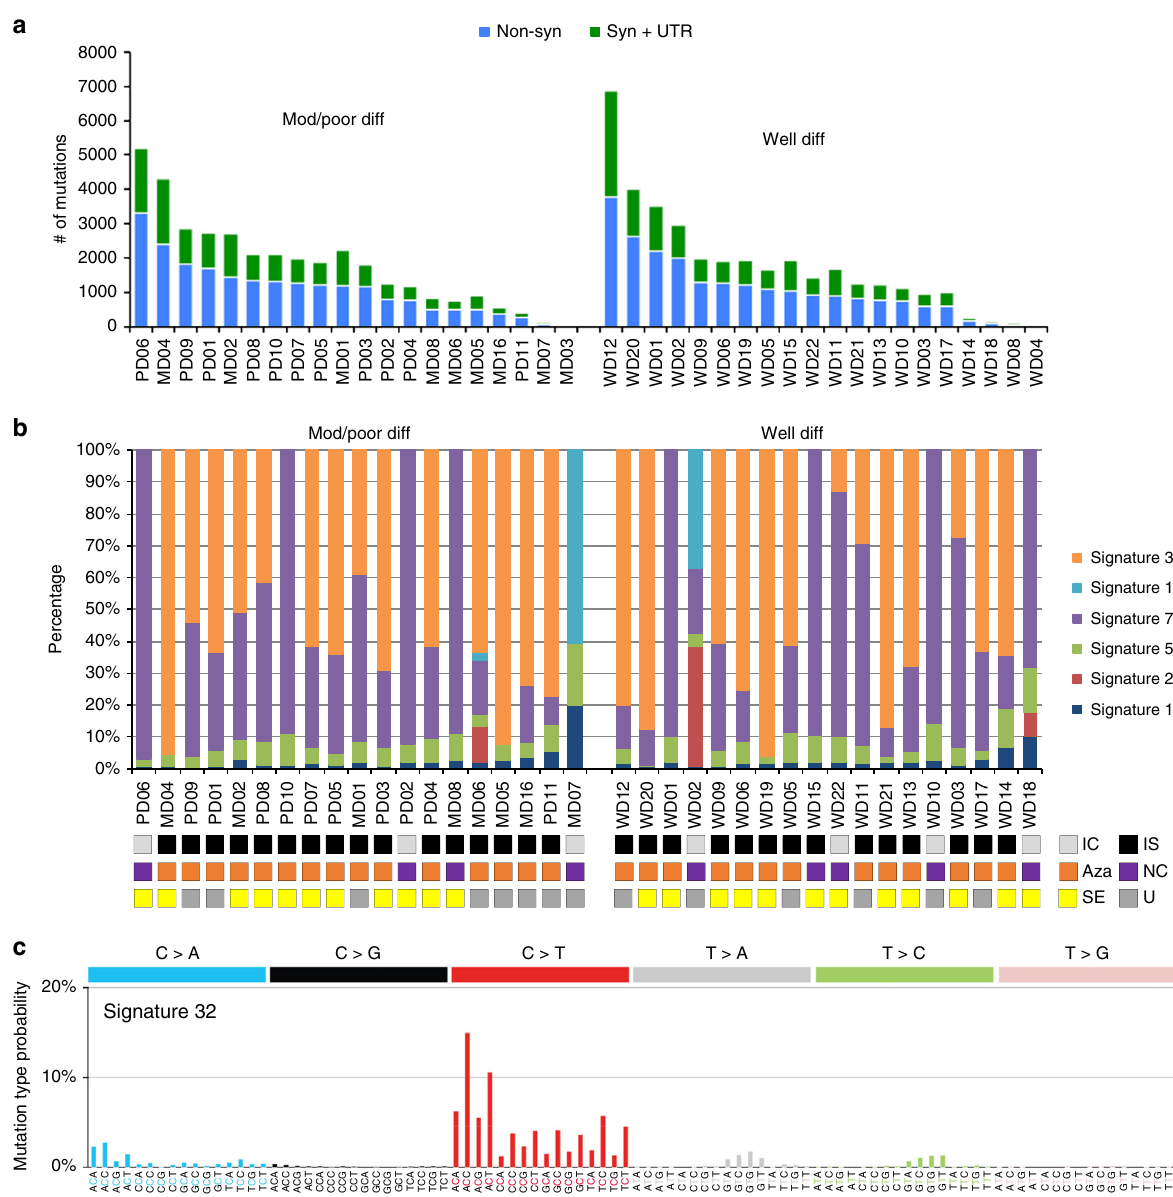
Fig. 1 Number of somatic mutations and mutation signatures across 40 cSCC samples in the moderate/poor and well-differentiated groups. a Number of nonsynonymous, synonymous and UTR mutations across 40 samples. b Mutation signature compositions across 37 of the 40 samples with suf fi cient mutation depth, in terms of moderate/poor and well-differentiated groups. IC immunocompetent, IS immunosuppressed, Aza con fi rmed azathioprine exposure, NC no con fi rmed azathioprine exposure, SE sun exposed site, U unknown if sun exposed site. c A novel signature, termed signature